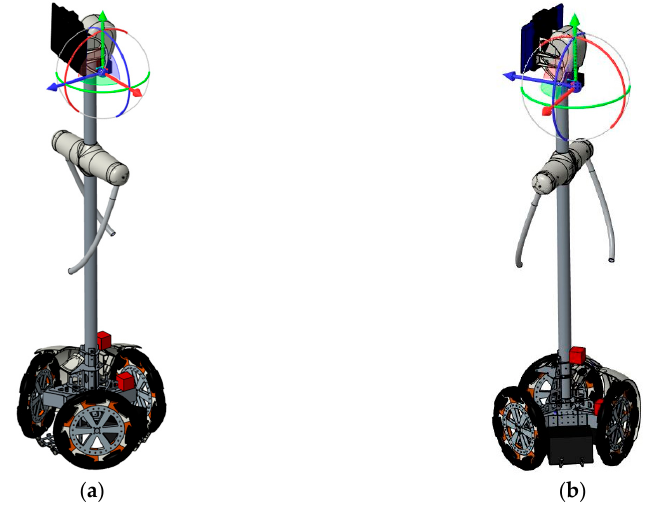
Figure 9. Mobile robot APR-1 with a red box representing the location of the accelerometers: front ( a ) and side ( b ) view. The longitudinal, normal, and side axes of the measurements are depicted with a blue, green, and red arrow, respectively.